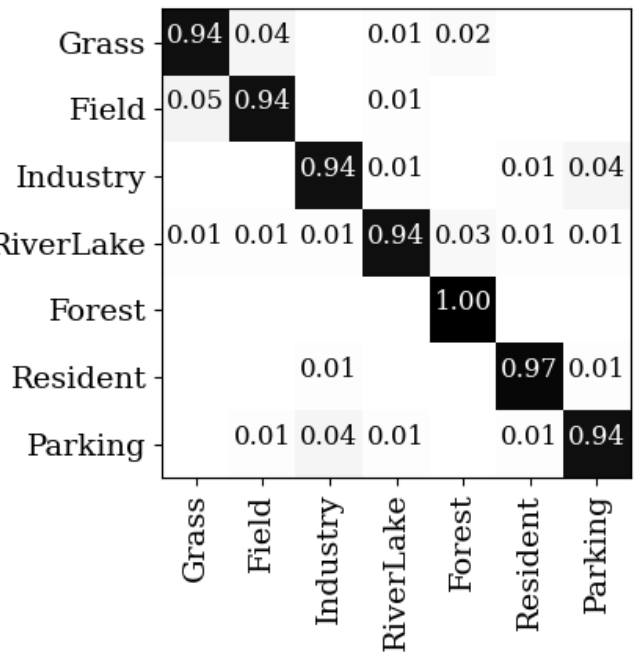
Figure 9. The confusion matrix on the RSSCN 7 dataset under the 50% training